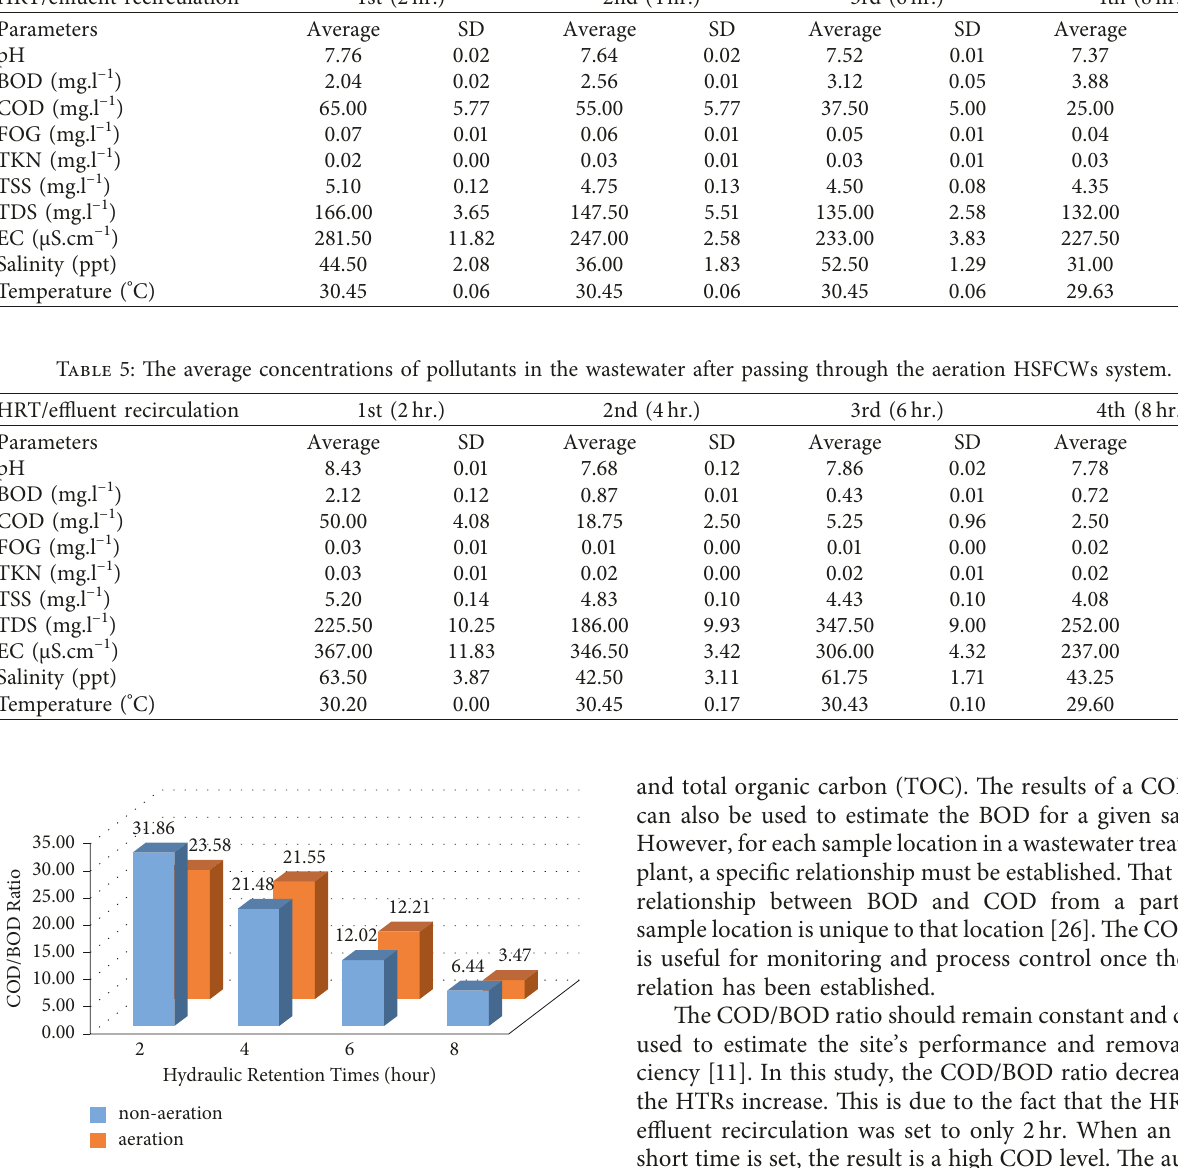
Table 4: The average concentrations of pollutants in the wastewater after passing through the nonaeration HSFCWs system. HRT/effluent recirculation